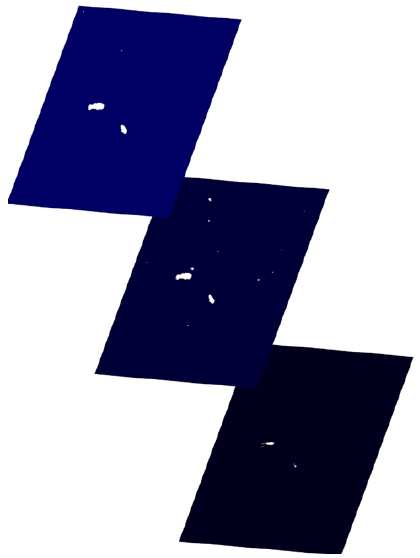
Figure 8. Zoom of Figure 7: comparison of the results obtained with classifier B+A, A, and B (from top to